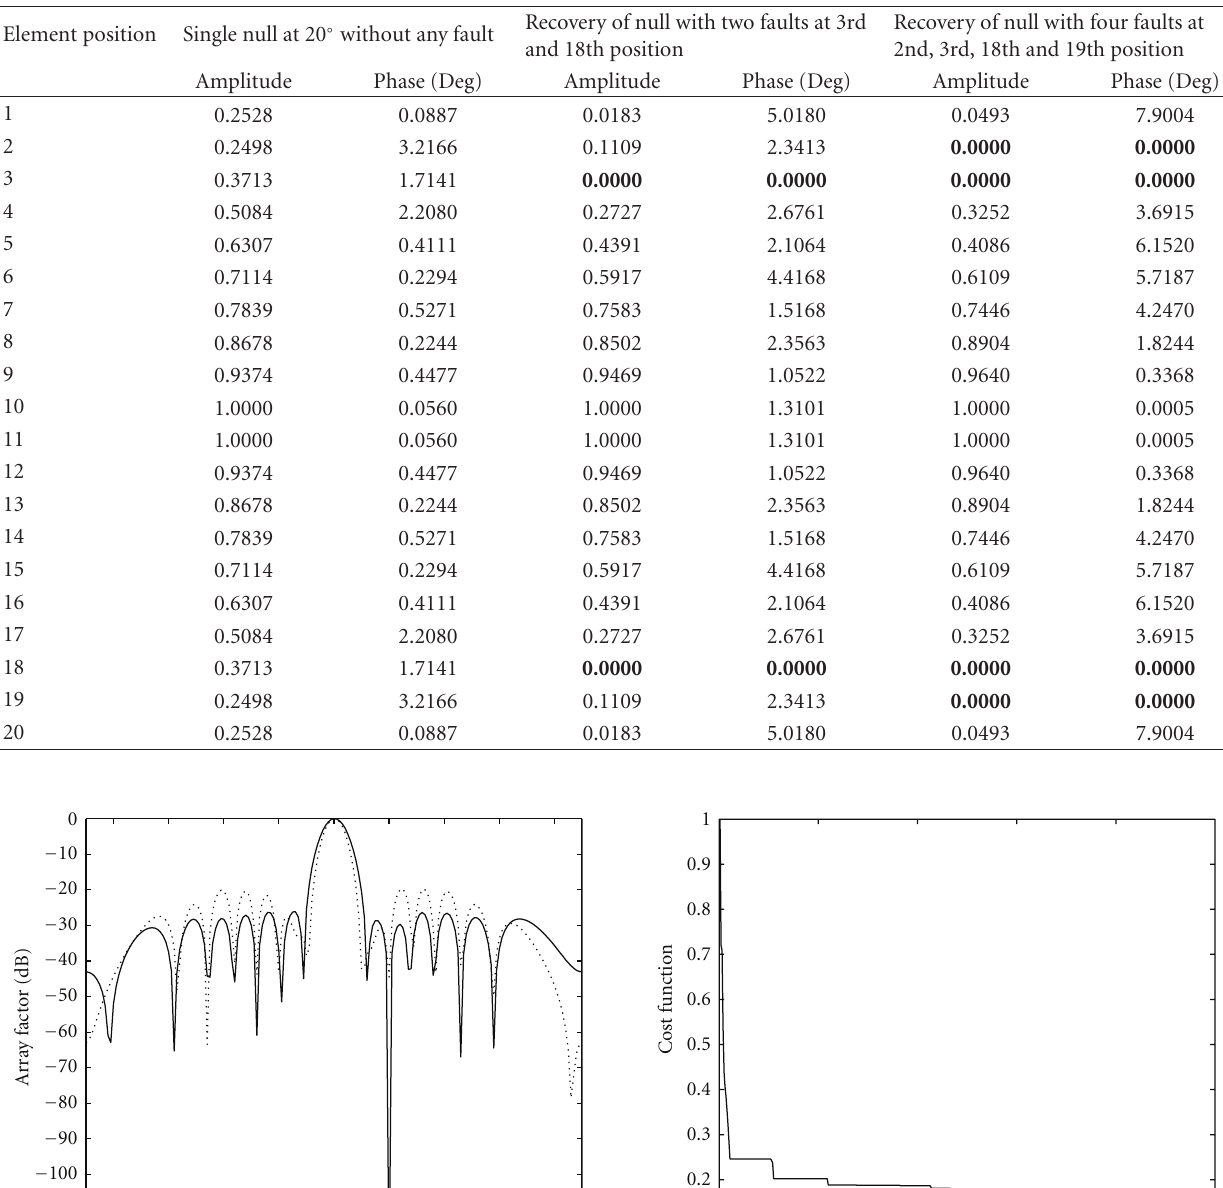
Table 1: Element excitations corresponding to Case 1.